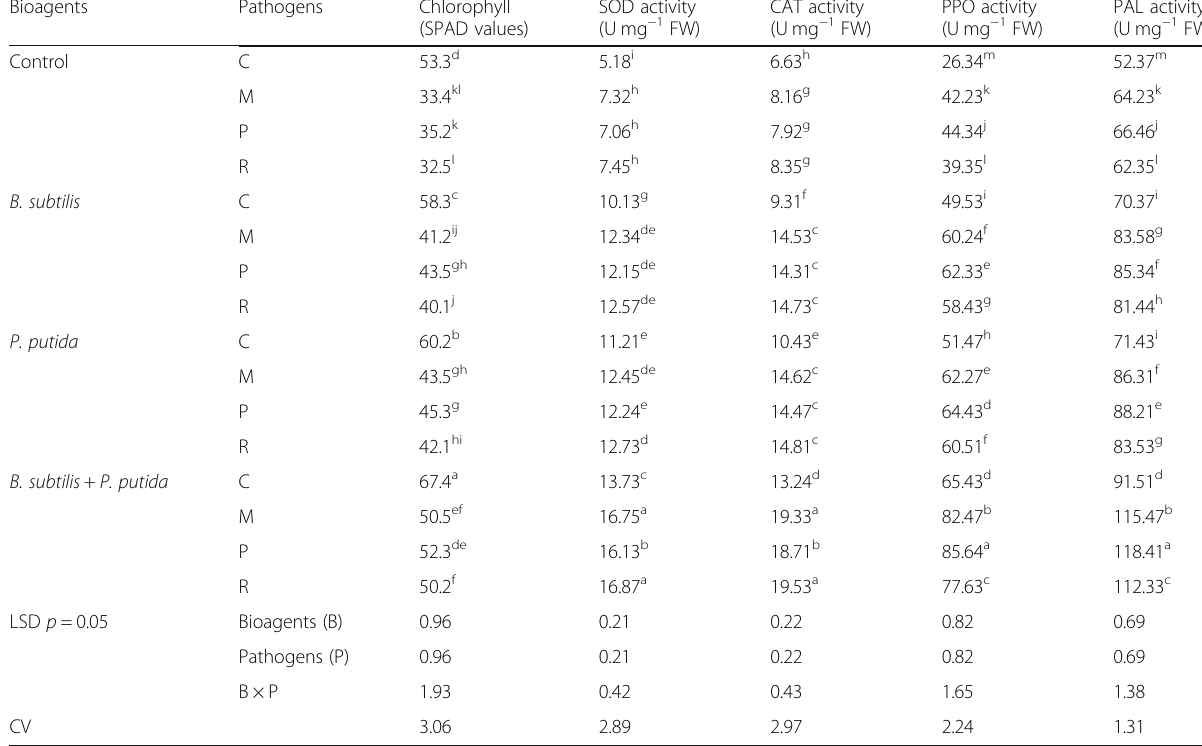
Table 2 Influence of Pseudomonas putida , Bacillus subtilis , and their mixtures on the chlorophyll content, and the activities SOD, CAT, PPO, and PAL of beetroot infected with Meloidogyne incognita , Pectobacterium betavasculorum , and Rhizoctonia solani